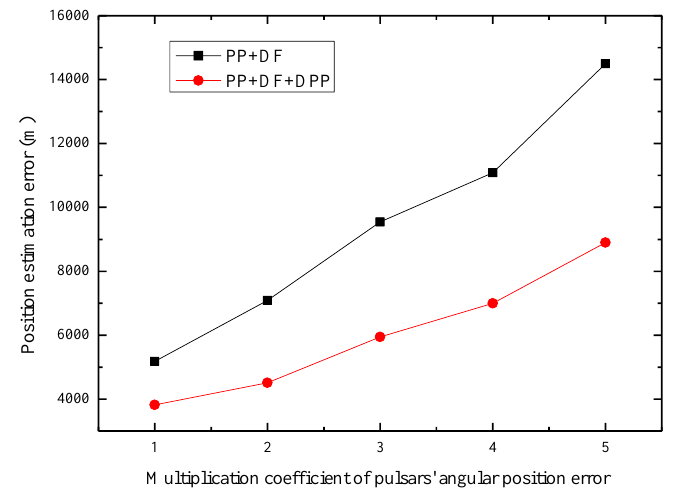
Figure 6. Performance comparison of different angular position errors.